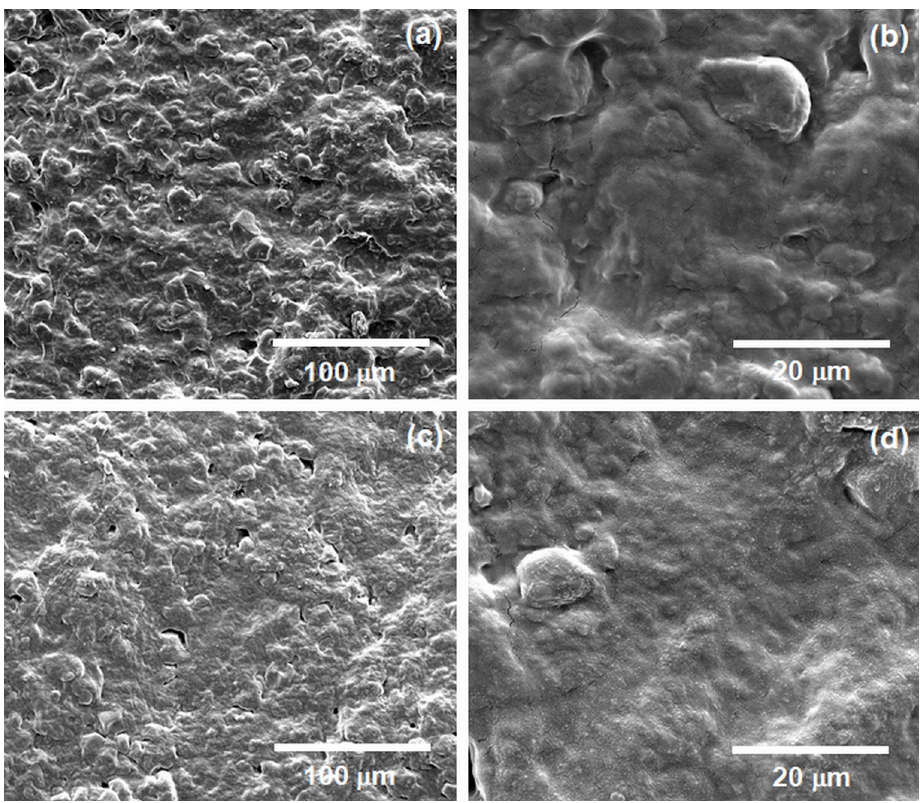
Figure 2. Surface morphology, obtained by SEM, of the TPS after plasma treatment: ( a ) HMDSO, 1000×; ( b ) HMDSO, 5000×; ( c ) He/HMDSO, 1000×; e ( d ) He/HMDSO, 5000×.